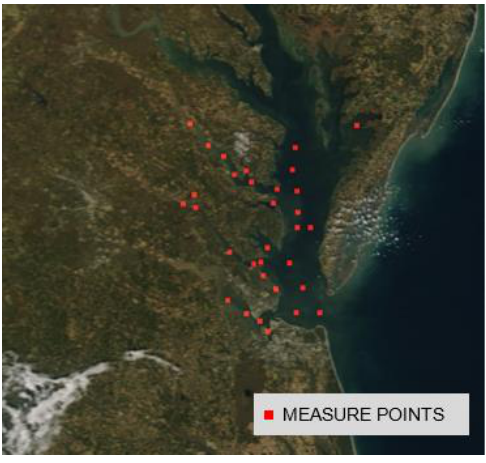
Figure 2 . Chesapeake Bay (Nasa,